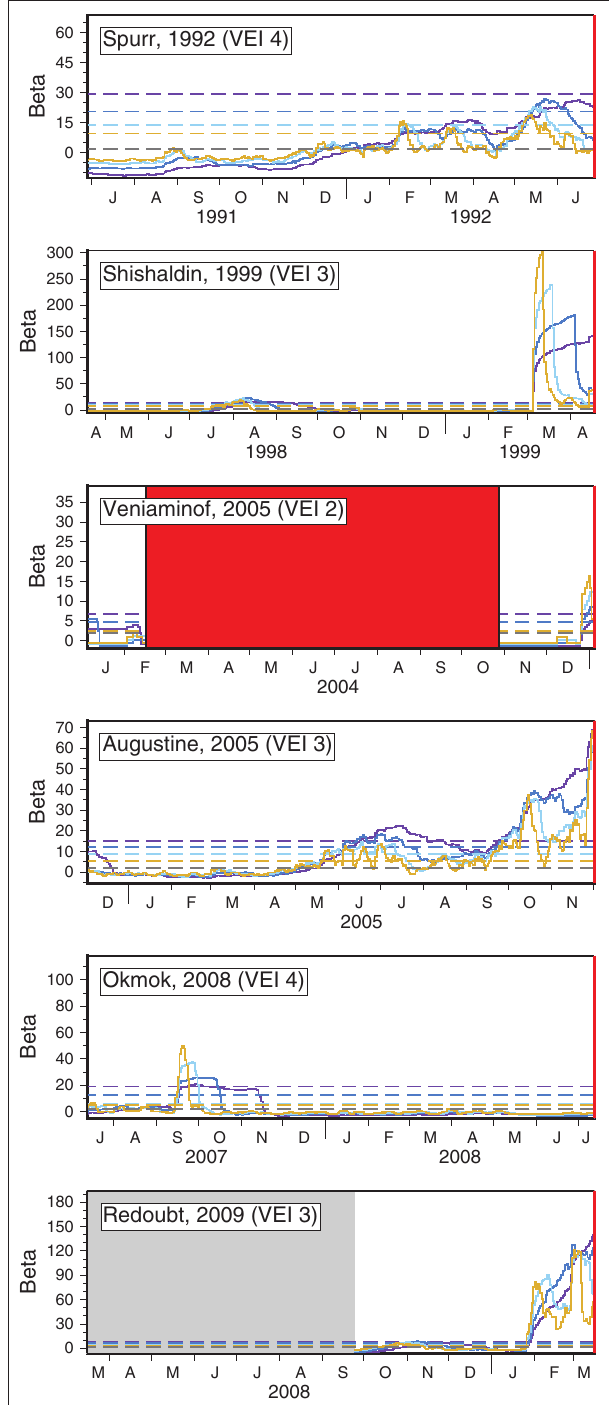
FIGURE 7 | Forward-computed β -statistic results for the 12 months prior to the eruptions shown in Figures 3 – 5 . In this case, the β -statistic was recomputed every day using R = 30km and events from the preceding T a = 7, 14, 30, and 60 days (brown, yellow, light blue, dark blue, purple; c.f. Figure 5 ). Note that no precursory anomaly is identifiable at Okmok because the computation occurs at the end of each day. Thus anomalies confined to the day of the eruption are not included. See Figures 3 , 5 and text for additional